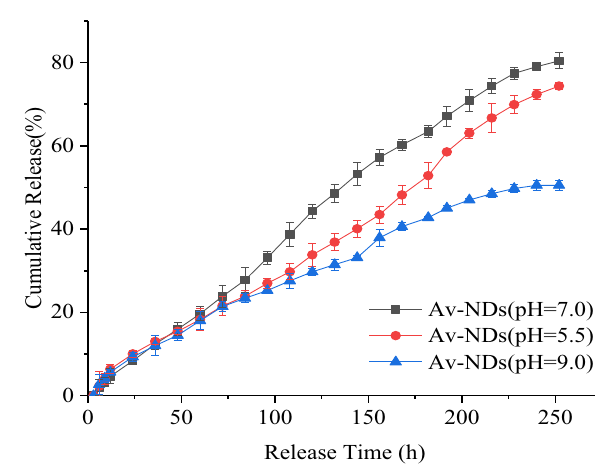
Figure 9. Release curve of Av-NDs in 70% methanol with different pH.